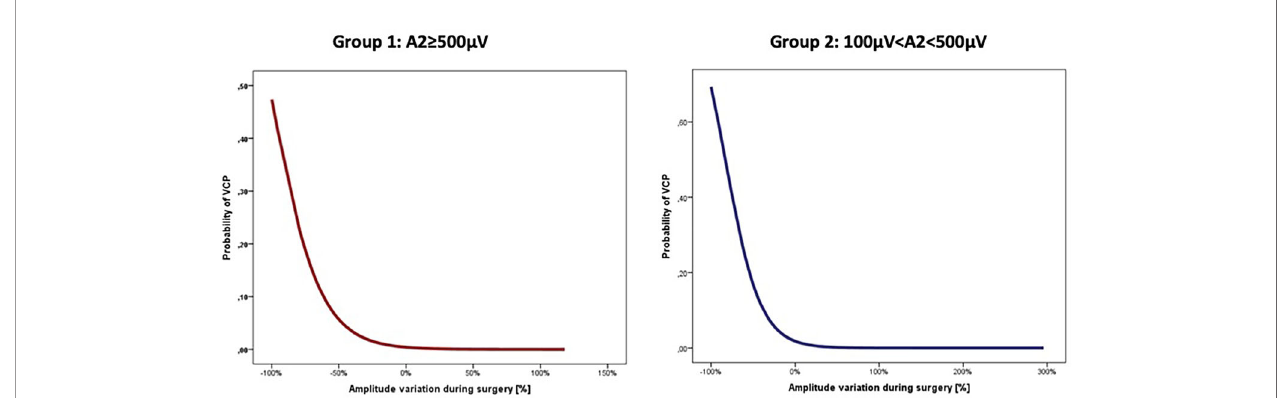
FIGURE 1 | Linear correlation between probability of VCP and amplitude variation during